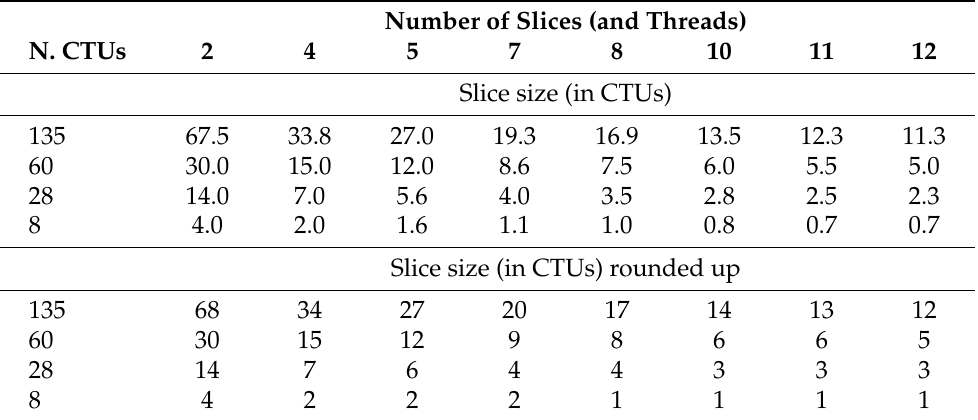
Table 5. Number of CTUs per slice.